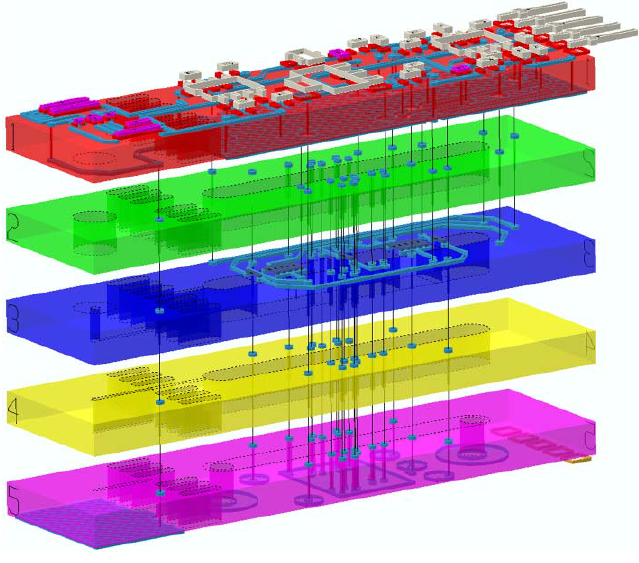
Figure 5. 3D, semi-transparent exploded view of the integrated sensor, showing the five LTCC tapes.